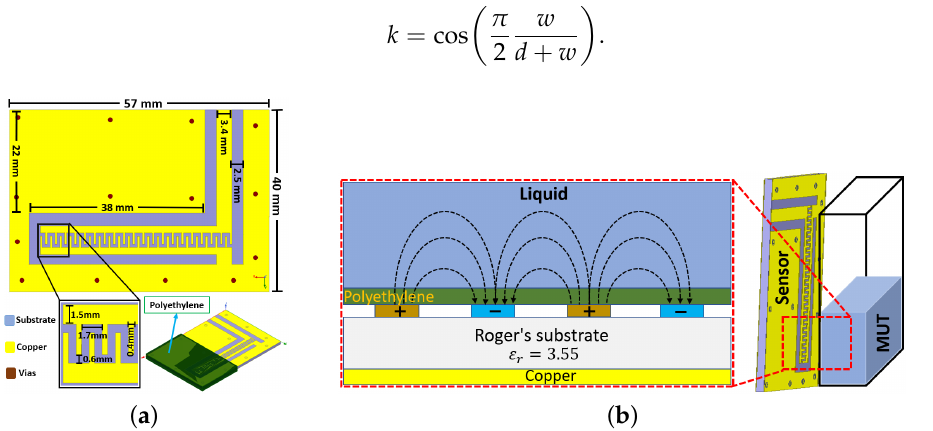
Figure 3. ( a ) Diagram of the proposed sensing element. ( b ) Schematic representation of the sens- ing